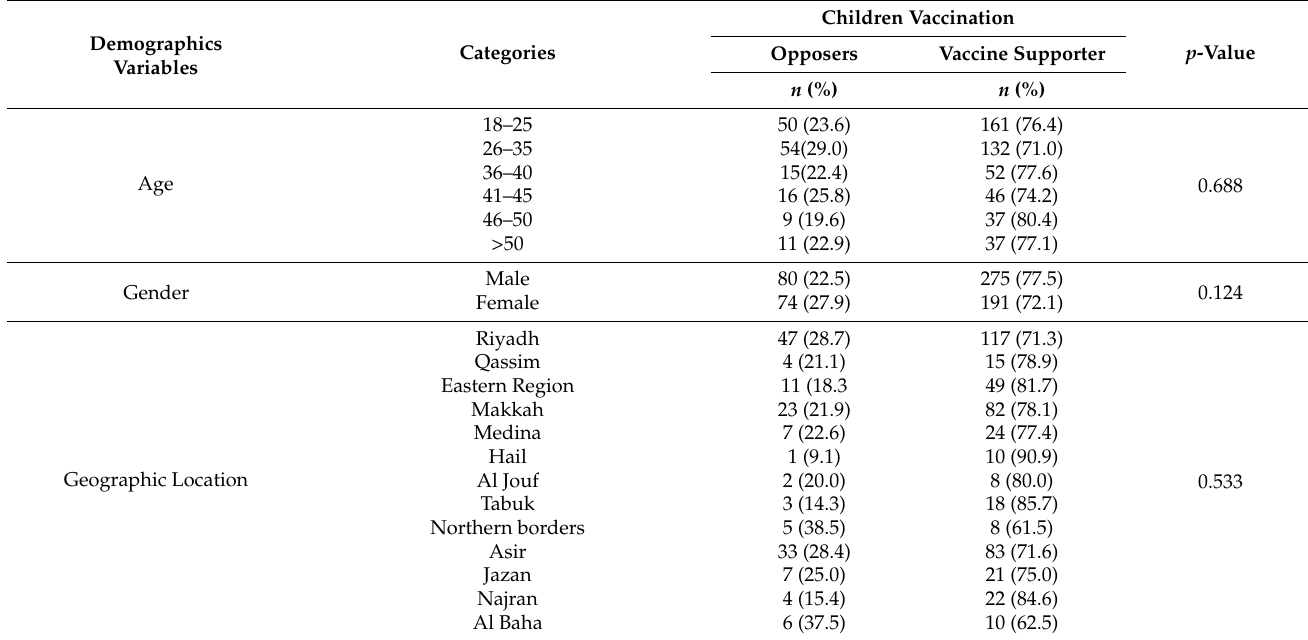
Table 3. Relationship between socio-demographic variables and participants’ attitudes towards children’s